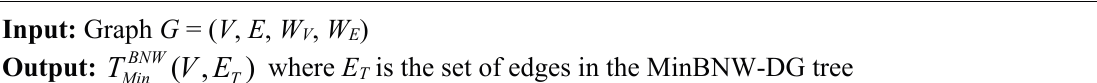
Algorithm 2. Pseudo Code for the Algorithm to Determine Minimum Bottleneck Node Weight-DG